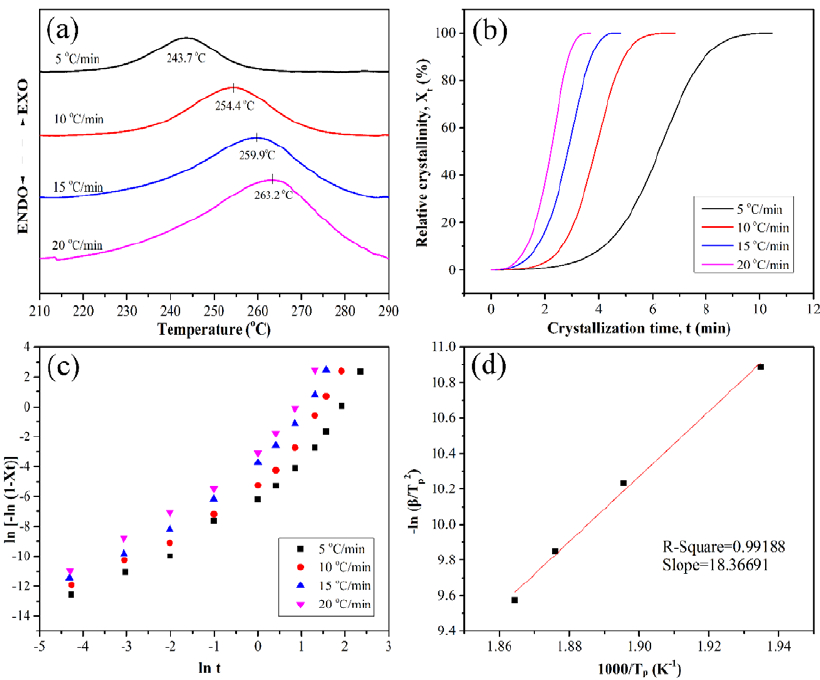
Figure 4. Crystallization behavior of the PEN ‐ Ph.